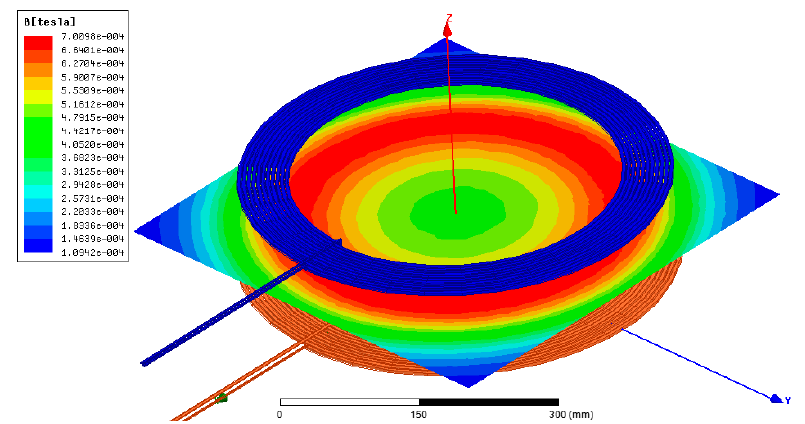
Figure 18. Magnetic field distribution of the pair of coils Coil1–Coil3.